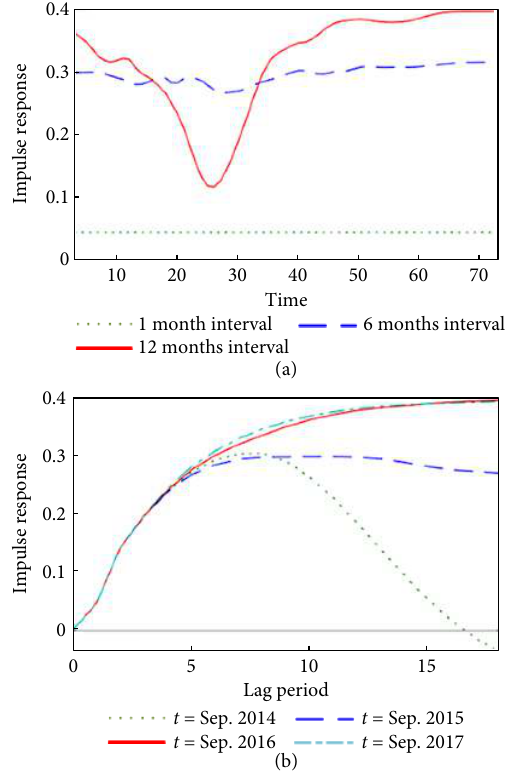
Fig. 3 Equidistant (a) and time-point (b) impulse responses of DTOM to Change_rate.